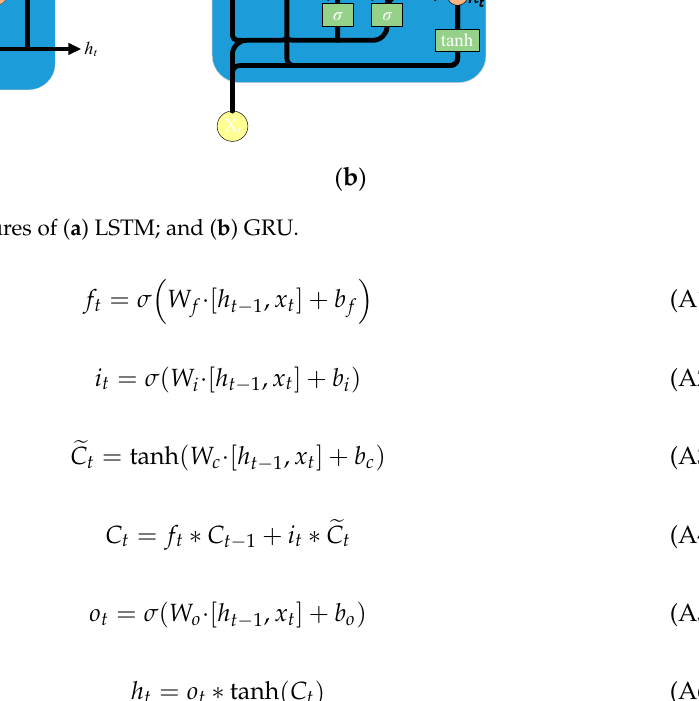
GRU is a variation on LSTM; the major difference is that it combines the forget gate and input gate into a single update gate. Other than some minor changes, the operational concepts are markedly similar. The final model is more streamlined than the original LSTM model. The calculations are presented in (A7)–(A10).